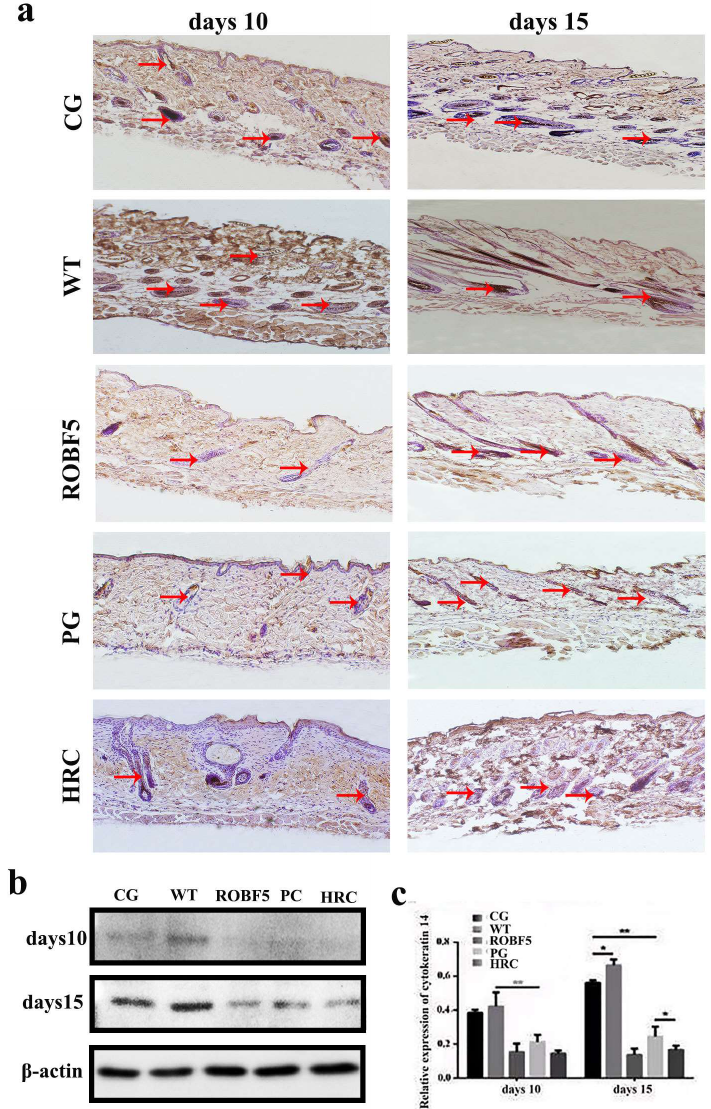
Figure 4. The expression of cytokeratin 14 analyzed in vivo by immunohistochemistry staining and Western blotting. ( a ) Immunohistochemistry staining of cytokeratin 14 (magnification of 100×), the red arrow indicates a positive protein. ( b ) Western blot analyzed the expression of cytokeratin 14. ( c ) The relative expression was calculated by the gray value of the Western blot (* p < 0.05, ** p < 0.01). CG: Control group (PBS), WT: wide-type oil body, PG: positive group (hFGF5), ROBF5: recombinant oil body expressing hFGF5, HRC: hair retardant cream.